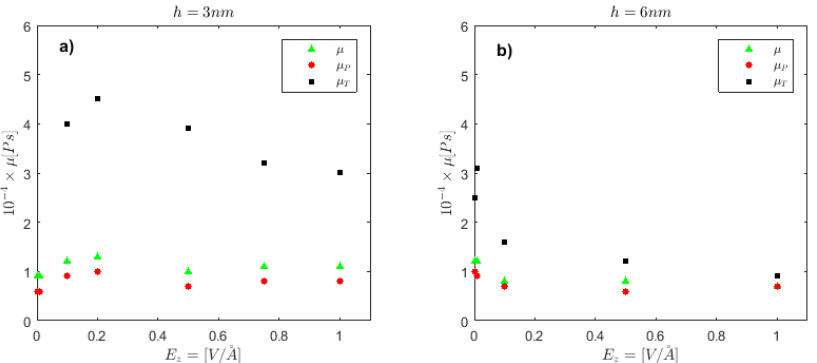
Figure 2. Shear viscosity, μ , in parallel and perpendicular to the wall direction, and as total channel value vs. the strength of the electric field, E , for ( a ) h = 3 nm and ( b ) h = 6 nm. Shear viscosity is also examined on its dependence on wall/fluid interaction 𝜀 𝜀 𝑤𝑓 𝑓𝑓